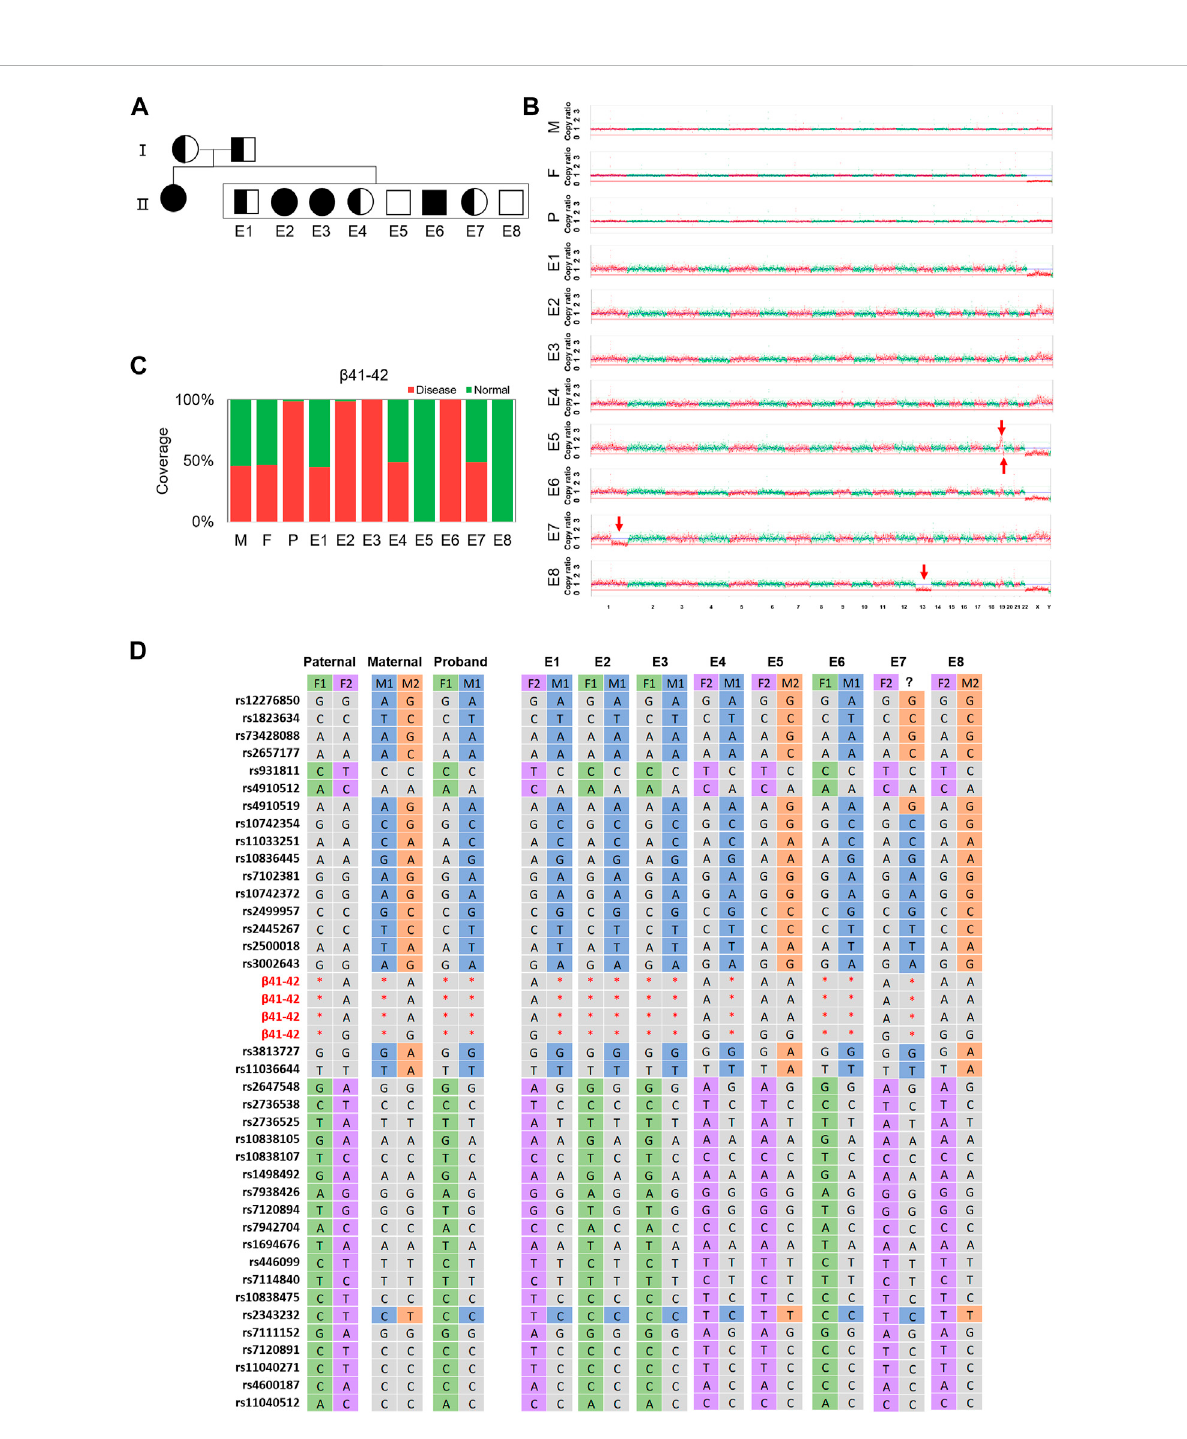
FIGURE 4 The results of TAGs-seq for family 5. (A) Pedigrees of the family with HBB. Filled symbols represent affected individuals; half- fi lled symbols represent carrier; opensymbols represent normal individuals.Circles and squares indicate femalesand males,respectively. (B) CNVs of theembryos at the low sequencing depth (0.25 – 0.46×) of TAGs-seq. Signi fi cant genomic imbalance was identi fi ed in embryos E8 (monosomy 13); E1, E2, E3, E4 and E6 did not identify genomic imbalance; A deletion was found in E5 (19q13.33-19q13.43,8.55M) and E7 (1q21.1-1q44,103.70M); A duplication was found in E5 (19q13.11-19q13.33,17.51M); (C) Direct detection the targeted mutation site inthe HBB gene of the father (F), themother (M), the proband child(P) and 8 embryos (E1 – E8) by TAGs-seq. E1, E4, E7 had one heterozygous mutated SNV (red), E2, E3, E6 had one homozygous mutatedSNVandE5,8hadnomutatedSNV.Thefractionofreadsofthecoveredregionshowningreenisconsistentwiththereferencegenome. (D) Genotypeofparentsandembryosofthe HBB geneplus37SNPscloselyassociatedwiththemutation.M1andF1werede fi nedasmaternalhaplotype 1 and paternal haplotype 1, respectively; meanwhile M2 and F2 stands for the maternal haplotype 2 and paternal haplotype 2, respectively. Red star, mutation; green/purple/blue/orange/grey, no